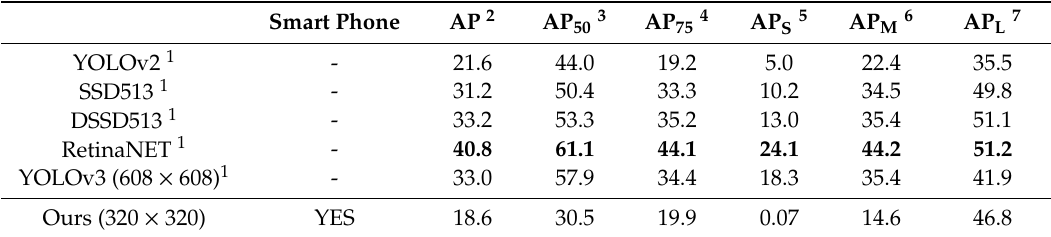
Table 3. COCO Dataset Detection